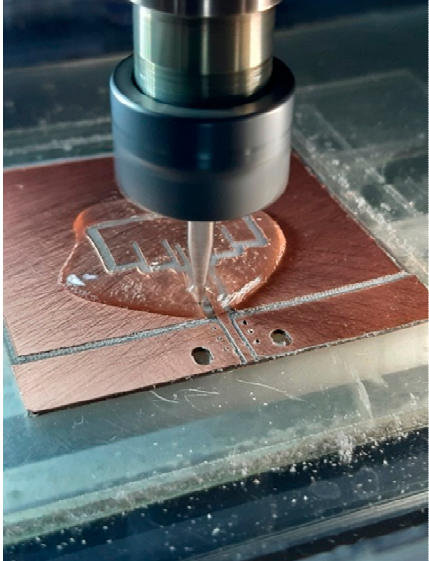
Figure 14. A detail of MPA3 manufacturing process.